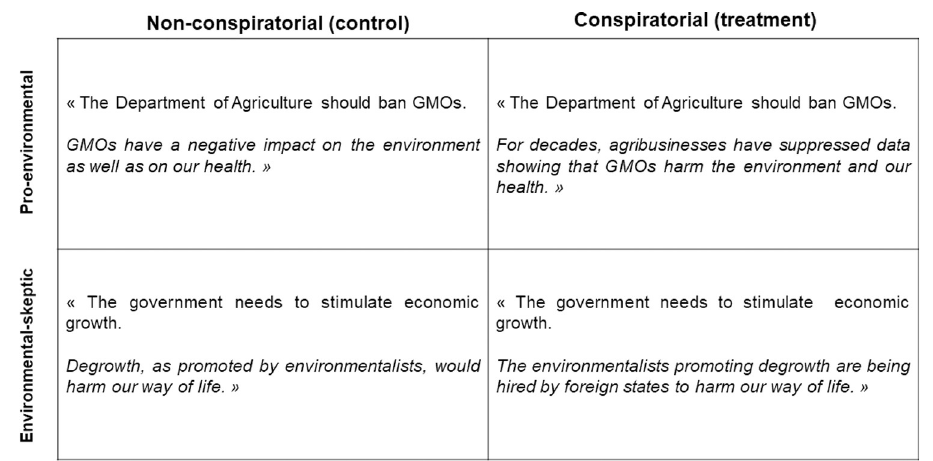
Fig 1. Illustration of experimental stimuli. Each statement is composed of two sentences. The first one, here written in ordinary type, corresponds to an environmental position and is identical across conditions. The second sentence, here written in italics, corresponds to a justification of the environmental position that varies across conditions, being either framed as conspiratorial (treatment condition) or not (control condition). Statements were paired with target photos taken from the Center for Vital Longevity Face Database